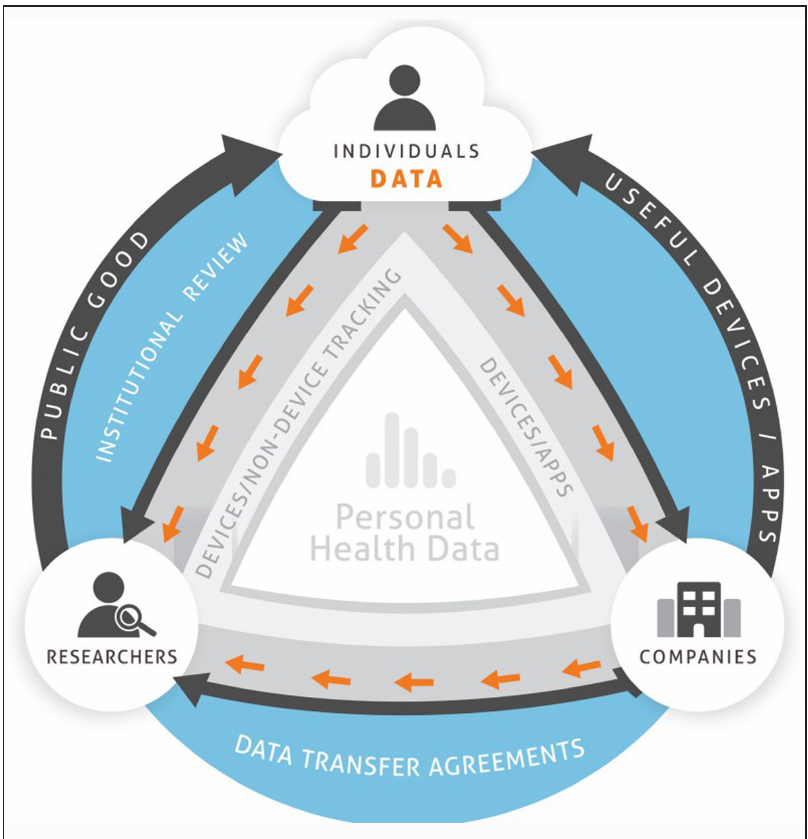
Figure 1: The Health Data Exploration Network brings together innovators in Personal Health Data to catalyze the use of personal data for the public